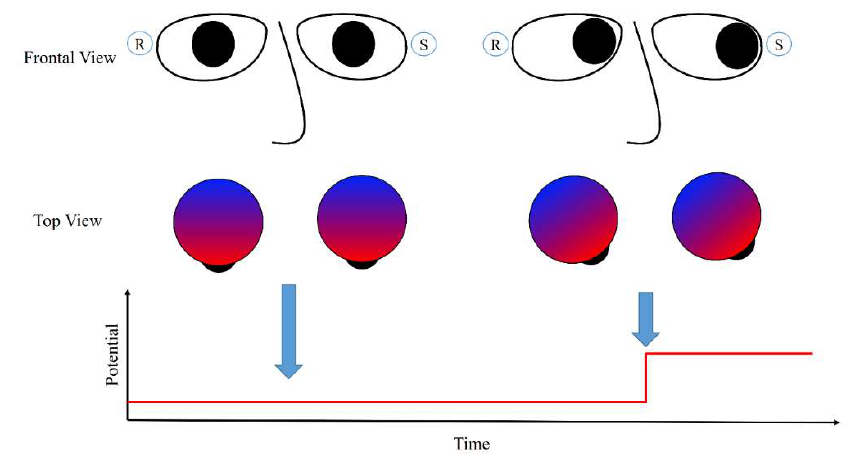
Figure 1. Illustrations of eye-movements and changes in electric potential around the eyes. S denotes the location at which a sensor is placed to record the EOG signal, and R is the location of a reference electrode.